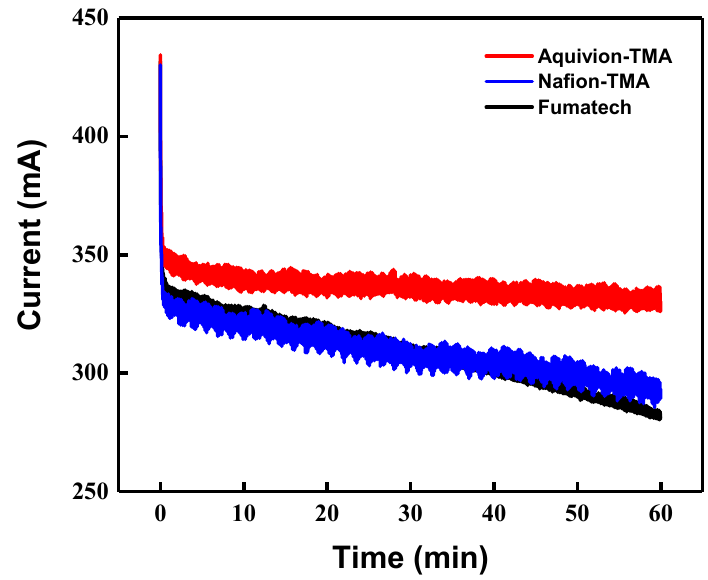
Figure 5. Variation in current during flow electrode capacitive deionization (FCDI) desalination using the different anion exchange membranes.